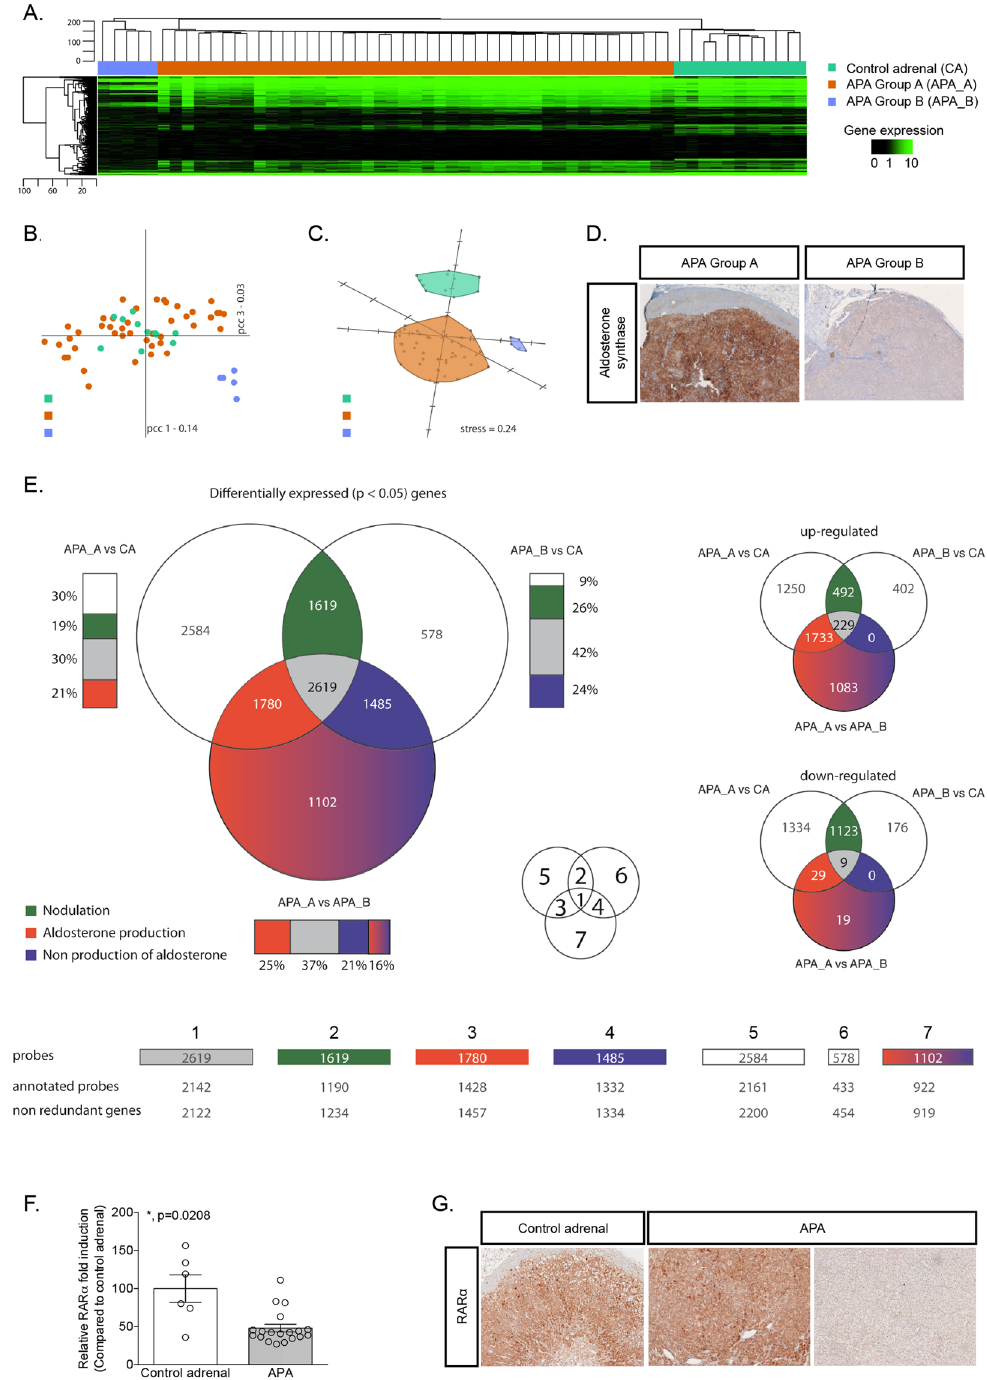
Figure 1. Transcriptome analysis reveals two distinct subgroups of APA. ( A ) Hierarchical clustering using Euclidean distance and complete linkage of 48 APA and 11 control adrenals. Heat-map of the whole gene expression is displayed using black for low expression and green for high expression. ( B ) Principal Component Analysis in the correlation space over the entire transcriptome. The first two principal components and their associated inertia are displayed. ( C ) Singular-value-decomposition-initialized multidimensional scaling under the correlation space over all genes 86,87 . Kruskal error is indicated as “stress”. ( D ) Aldosterone synthase immunohistochemistry performed on adrenals from APA_A and APA_B. ( E ) Three groups (APA_A, APA_B and CA) are pair-wise compared to obtain a list of statistically significantly expressed candidate genes for each of the three comparisons. The common and comparison-specific genes are classified in seven different groups some of which are associated to a biological process. Venn-diagrams are displayed for statistically significantly differentially expressed candidate genes. The smaller Venn diagrams on the right-hand side of the figure represent the overlap for up-regulated and down-regulated genes. Bars are displayed next to the